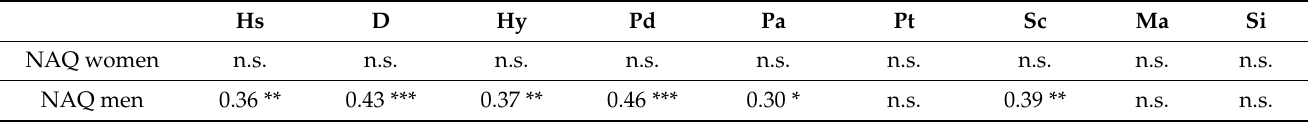
Table 7. Gender differences in correlations between the NAQ and MMPI-2 clinical scales. Hs